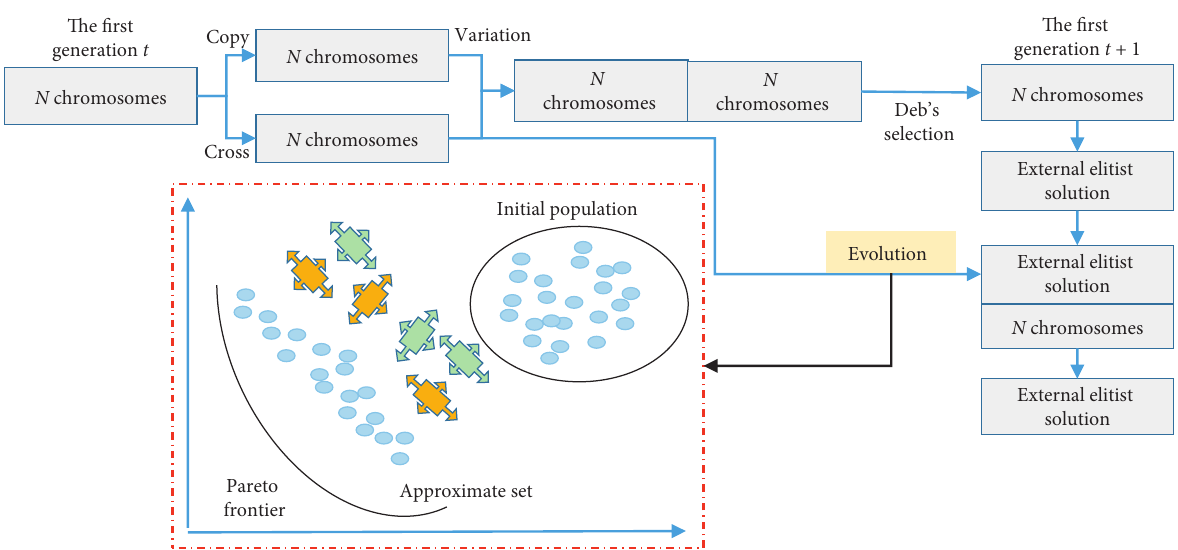
Figure 3: Multiobjective evolutionary